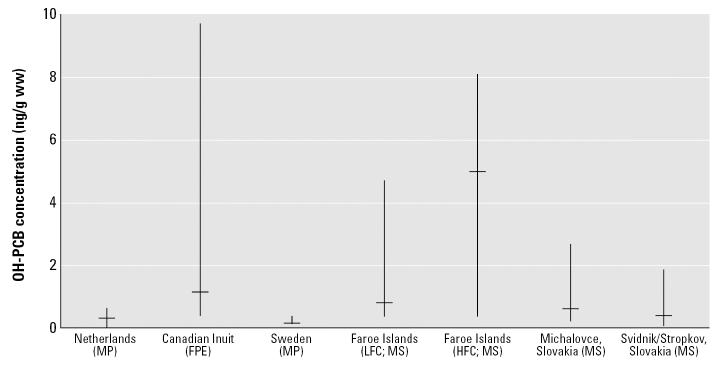
Medians and ranges of maternal blood concentrations of major OH-PCB metabolites from five other areas for comparison to present data. Abbreviations: FPE, female plasma equivalent; HFC, high fish consumption; LFC, low fish consumption; MP, maternal plasma; MS, maternal serum. The samples were collected for the Netherlands in 1998–2000 (Soechitram et al. 2004), Canadian Inuit in 1992 (Sandau et al. 2000), Sweden in 2000–2001 (Meironyté Guvenius et al. 2003), Faroe Islands in 1994–1995 (Fängström et al. 2002), and Michalovce and Svidnik/Stropkov in 2002–2004 (present study). The distribution for the Slovak region represents the 1,103 mothers through weighting based on the sample design.